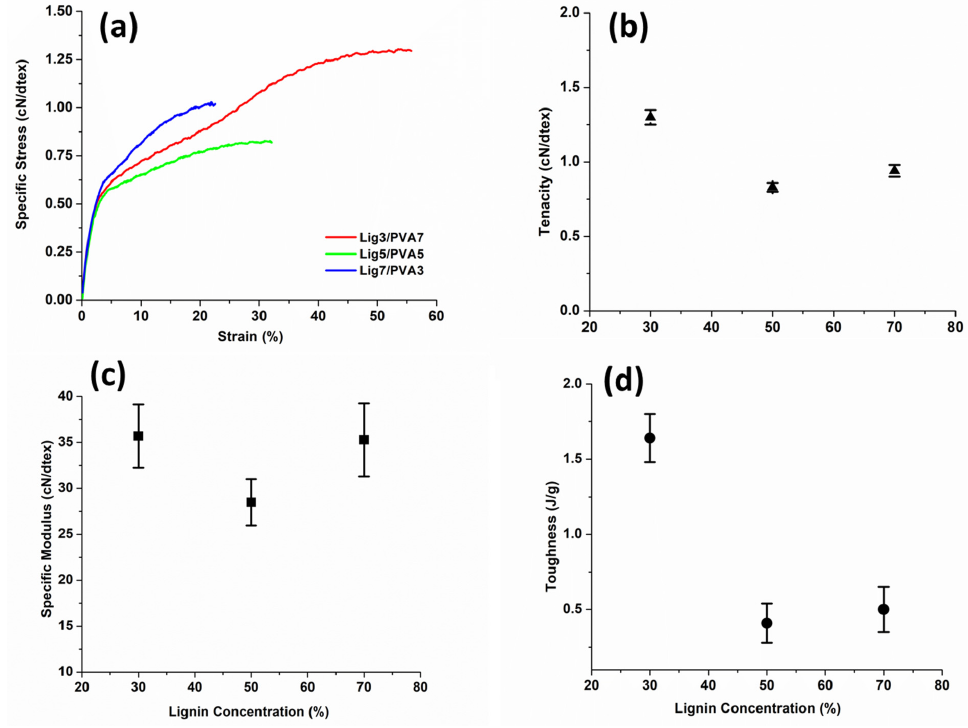
Figure 6. Tensile profile: ( a ) specific stress versus strain, ( b ) tenacity, ( c ) specific modulus, and ( d )